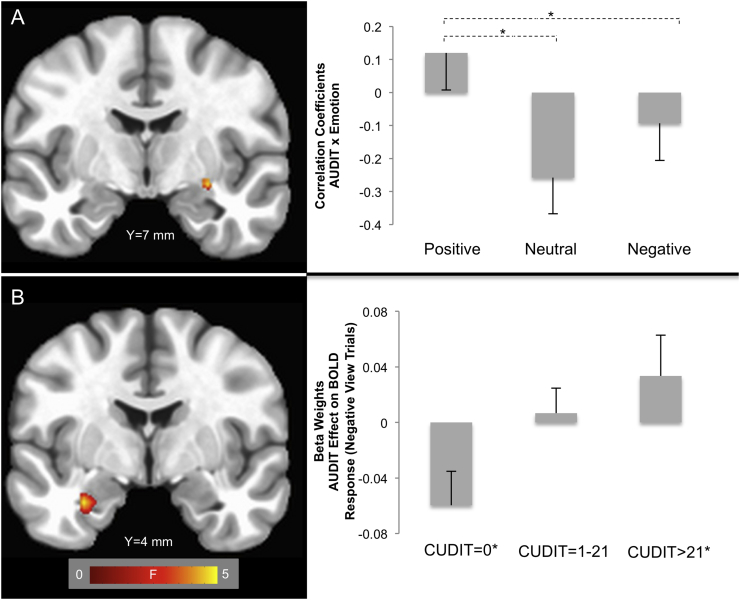
AUDIT-by-emotion interaction within the (A) Amygdala ROI (x = 29 mm, y = −7 mm, z = −7 mm). Participants with higher AUDIT scores showed increased responses to emotional relative to neutral stimuli (k = 5 voxels). Values in the bar graph represent the correlation coefficients between AUDIT scores and BOLD responses for each emotion; * indicates significant differences between partial correlation values (Steiger's Z > 1.96, p < 0.05). (B) AUDIT-by-CUDIT interaction effect within the negative view trials (k = 9 voxels). Values in the bar graph represent the beta weights for the effect of AUDIT score on BOLD response within the range of CUDIT scores indicated. * indicates regions of interest significant at p < 0.05 identified via the Johnson-Neyman technique.